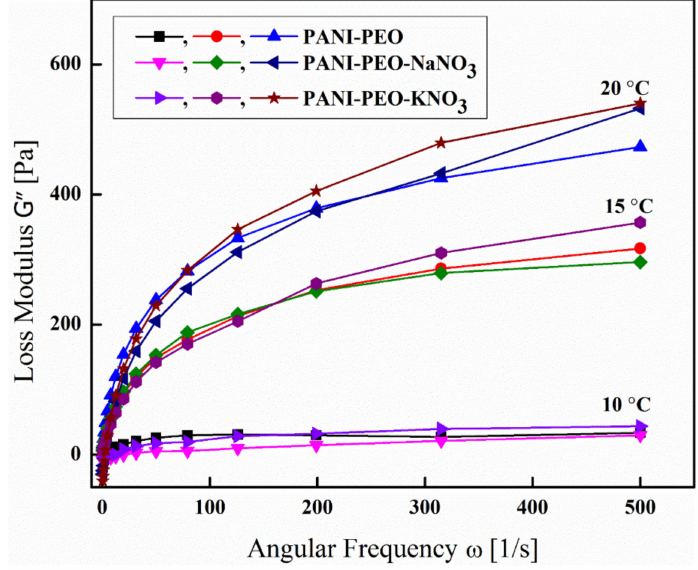
Figure 9. Rheogram of ( a ) PANI-PEO ( b ) PANI-PEO-NaNO 3 and ( c ) PANI-PEO-KNO 3 showing dependence of loss modulus on angular frequency at 20 ◦ C, 15 ◦ C and 10 ◦